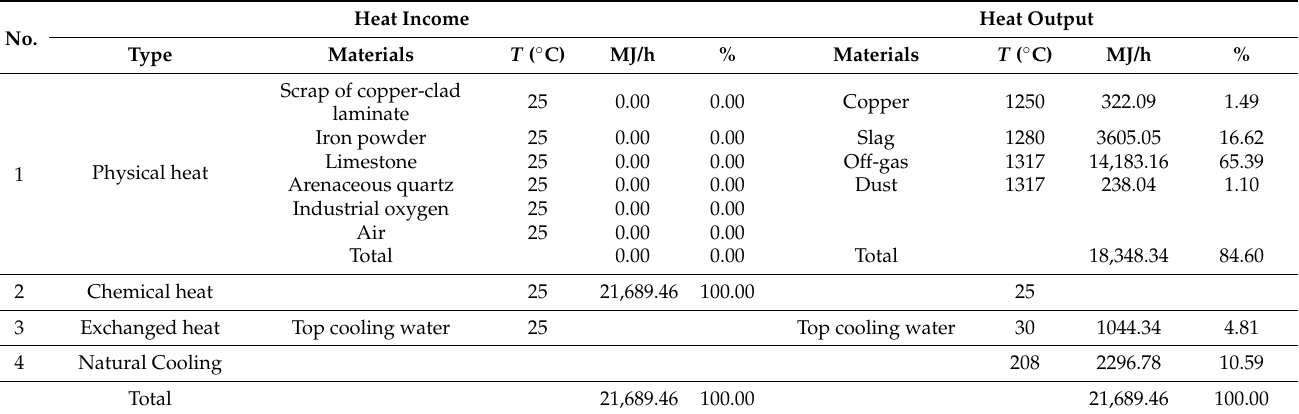
Table 6. Heat balance of input–output in NRT smelting of electronic waste.